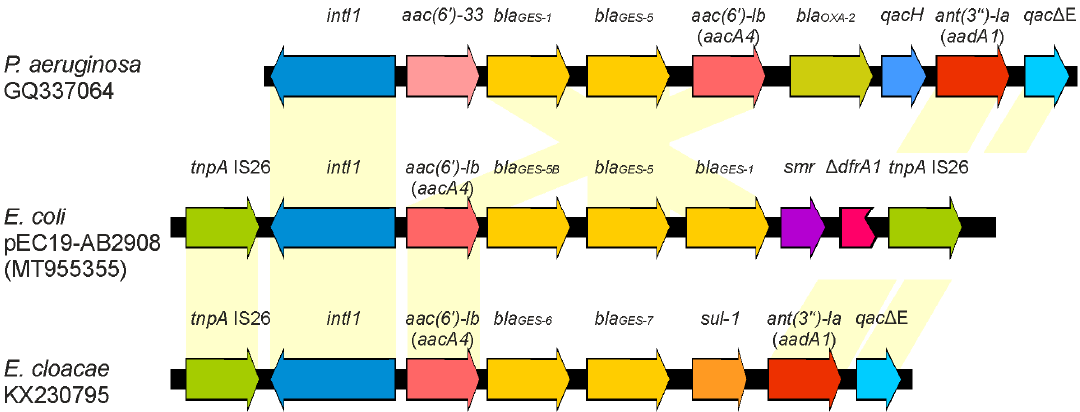
Figure 1. Comparison of the sequence organization of the bla GES region with similar integrons available at GenBank [17,18]. The reading frames are presented with arrows; arrowheads indicate the direction of transcription.